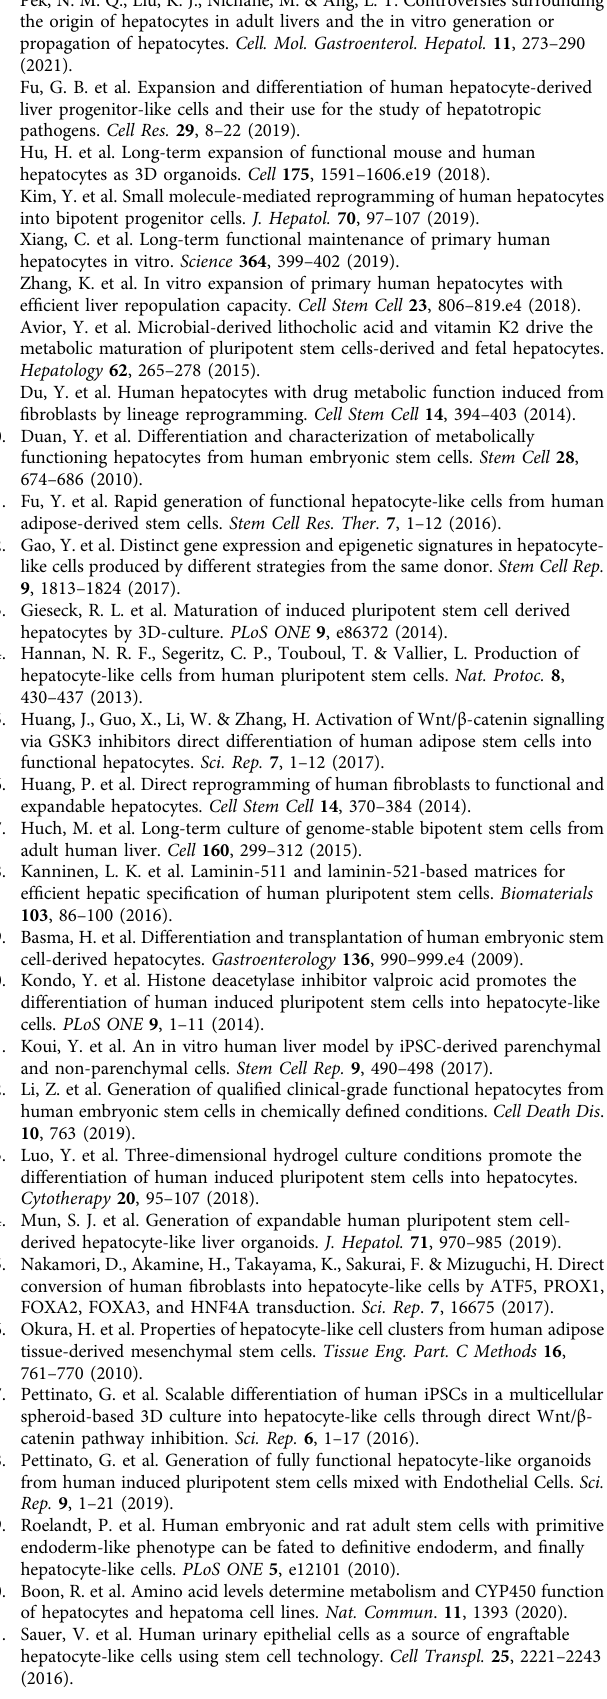
Fig. 2 served as a training dataset to build the classi fi er. A dataset is not recom- mended to be used when the new PHH/liver samples have PHH/liver classi fi cation probability below